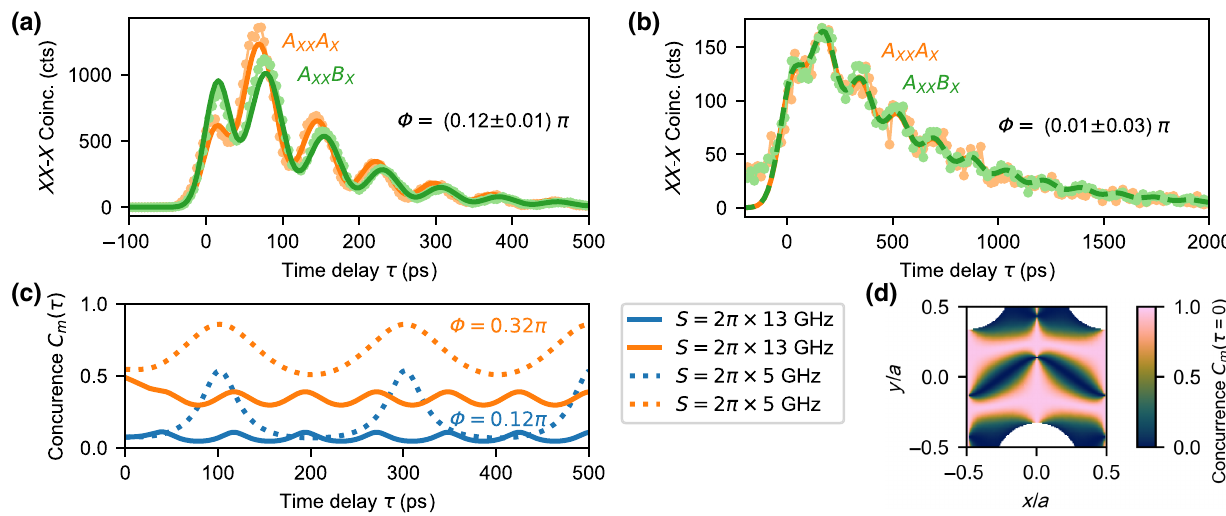
FIG. 3. Observation of path-dependent correlations of the entangled state. (a) Path-dependent photon correlation measurements of QDs in GPW in two configurations, A XX B X and A XX A X . Solid lines are fits to the theoretical model. The error in (cid:5) is the 1 σ confidence interval fitting error. (b) Similar measurements as (a) but from a QD in a regular photonic crystal waveguide with no significant chiral interaction. (c) Time-dependent measurable concurrence C m (τ) accounting for detector timing jitter. The solid blue curve is calculated for a QD in the GPW under current experimental conditions ( (cid:5) = 0.12 π , S = 2 π × 13 GHz, γ X = 8.35 ns − 1 , ς = 15 ps). The blue dotted line uses a smaller S = 2 π × 13 GHz, corresponding to experimental parameters of a previously studied device [14]. The orange curves show both cases of S but for the absence of back reflections where (cid:5) = 0.32 π (see main text). (d) Predicted QD position-dependent C of the path-entangled state at time τ = 0 within the GPW exhibiting wide areas of near-perfect entanglement. The concurrence is calculated using the theoretical model [22], and the simulated phase plotted in Fig. 1(b). evidence of chiral coupling resulting in path